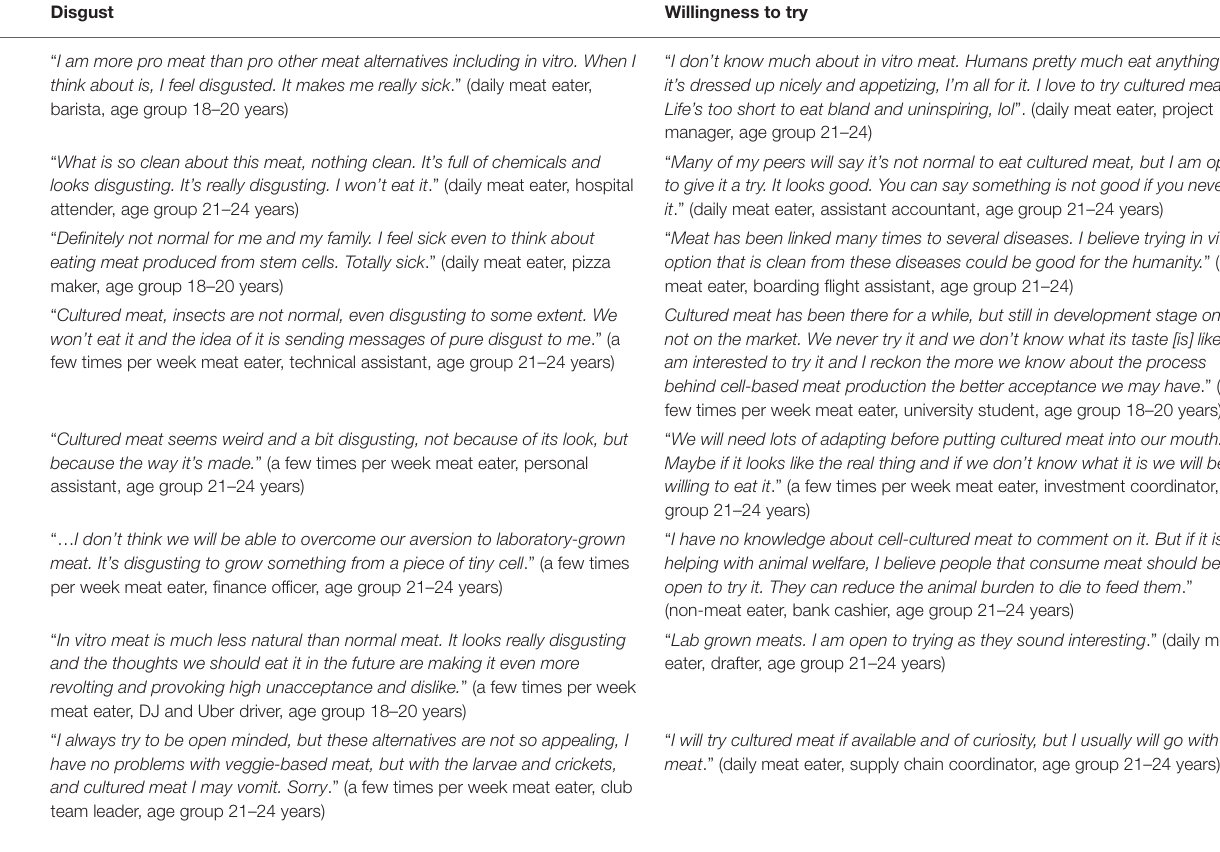
TABLE 2 | Sydney Gen Z’s disgust and willingness to try cultured